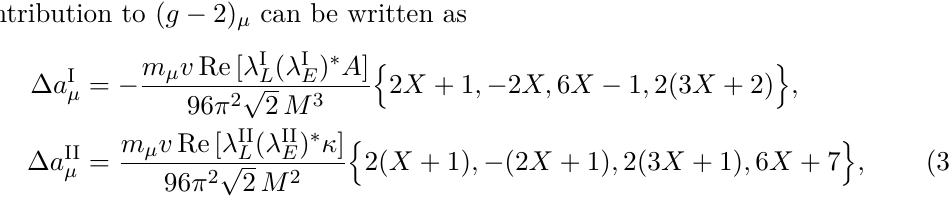
Figure 2 . Modification of h → µµ for R = 121 in case I, as a function of hypercharge X (left), and for fixed X = − 1 / 2 , but with variable mass parameters x L,E = M 2 (right). In both cases regions in parameter space where the modification stays below 1% are marked in blue, those with coupling | A/M | > 3 in red. The mass parameter is set to M = 1 TeV, and the central value of ∆ a µ has been